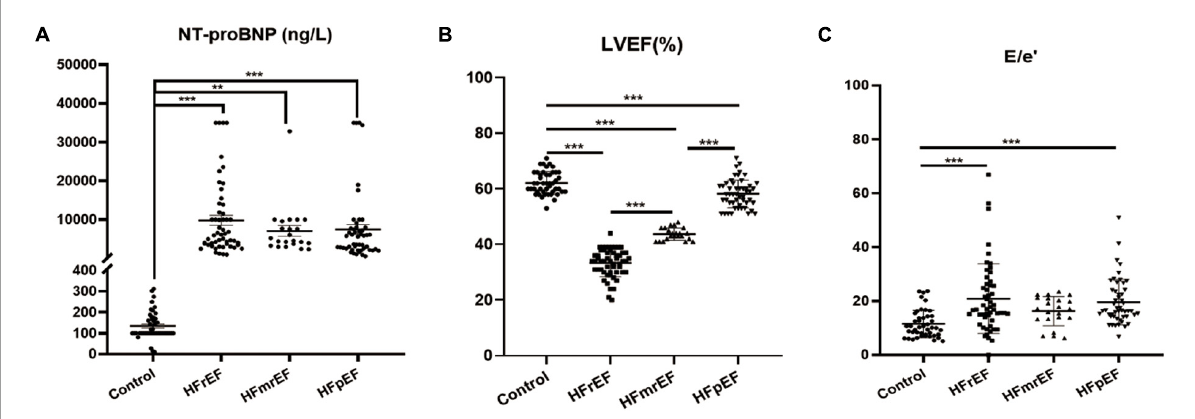
FIGURE1 Visualized analysis of important parameters in diagnosing HF phenotypes. (A) The comparison regarding the expression of NT-proBNP among Control, HFrEF, HFmrEF and HFpEF groups. (B,C) The comparison of LVEF and E/e (cid:48) ratio revealed from echocardiography among the four groups. Control, non-heart failure participants; HFrEF, heart failure with reduced ejection fraction; HFmrEF, heart failure with mildly reduced ejection fraction; HFpEF, heart failure with preserved ejection fraction; NT-proBNP, N-terminal pro-B-type natriuretic peptide; LVEF, left ventricular ejection fraction; E/e (cid:48) , transmitral early (E)/mitral annular early (e (cid:48) ) diastolic velocity ratio. ** P < 0.01, *** P <